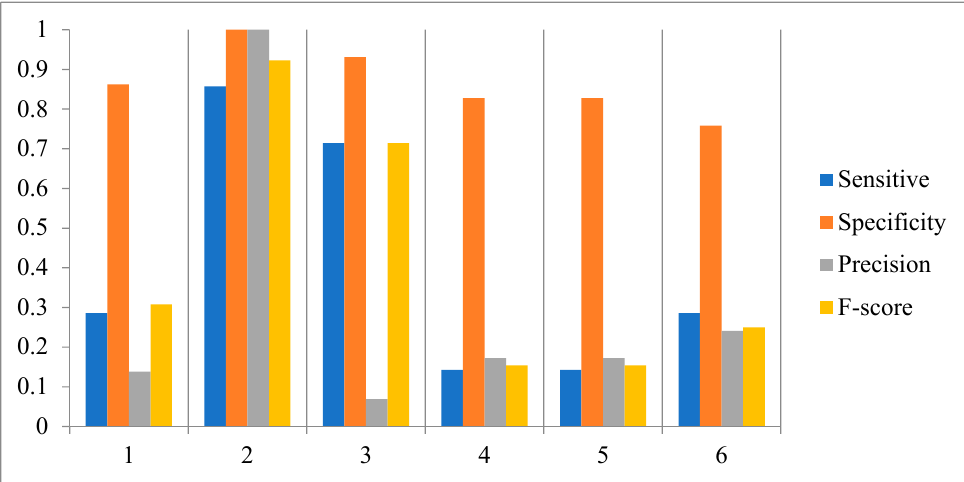
Figure 10. Effect of parameter L for SOS network inference.